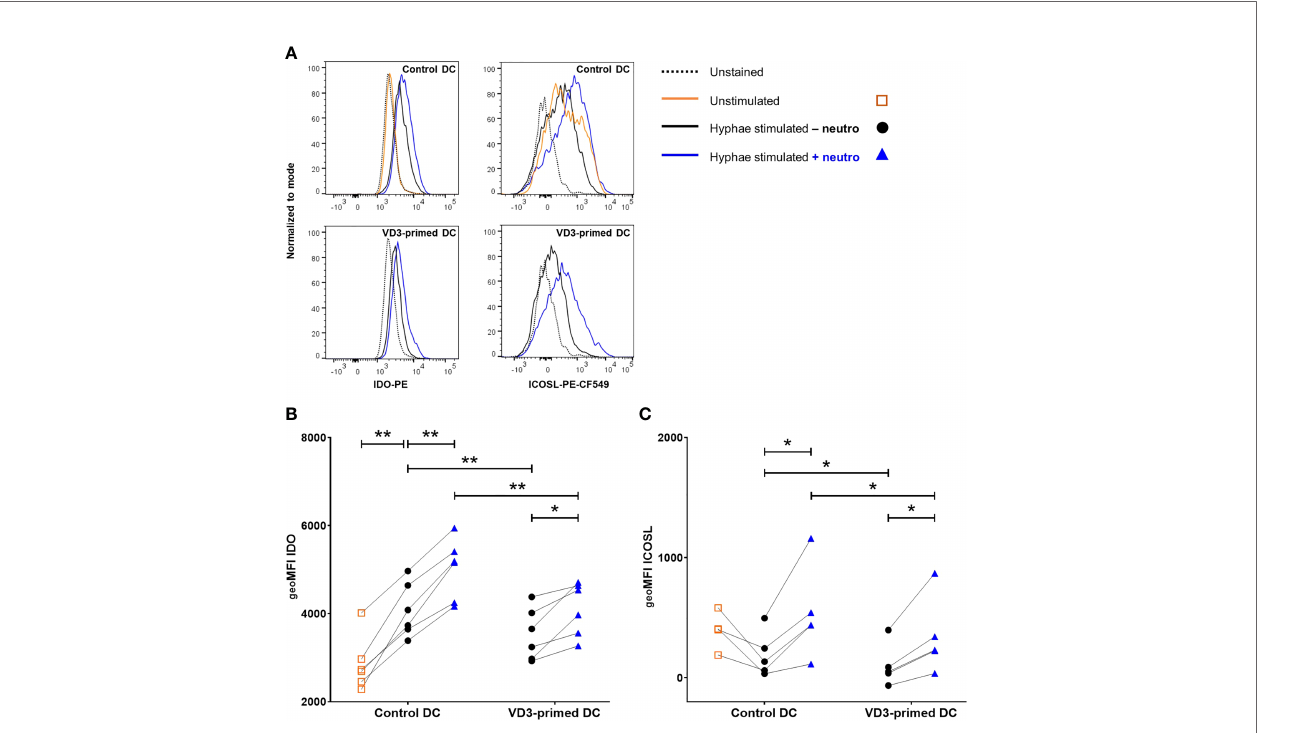
FIGURE 5 | Indoleamine-2,3-dioxygenase (IDO) and inducible costimulatory ligand (ICOSL) expression in DCs is increased by neutrophils. (A) Intracellular IDO expression and ICOSL surface expression on control or VD3-primed DCs are shown, either unstimulated or stimulated with C. albicans hyphae in the presence or absence of neutrophils. Representative histograms are depicted. (B) Intracellular IDO expression is shown as geoMFI ( n = 6). (C) ICOSL on DCs is depicted as geoMFI ( n = 5). One-way ANOVAs with Holm – Sidak ’ s post hoc test were performed. * p < 0.05, ** p <